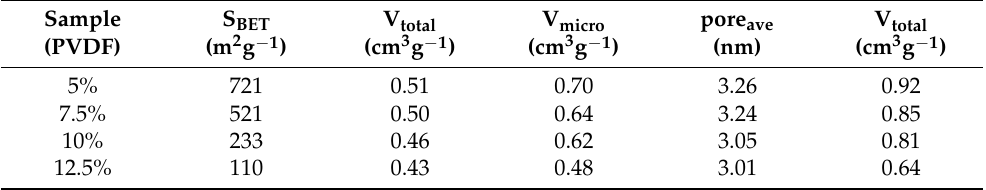
Figure 7. Brunauer–Emmett–Teller (BET) ( a ) isotherm and ( b ) pore size analysis of perpend elected at various PVDF concentration. Table 2. Surface area analysis from BET.